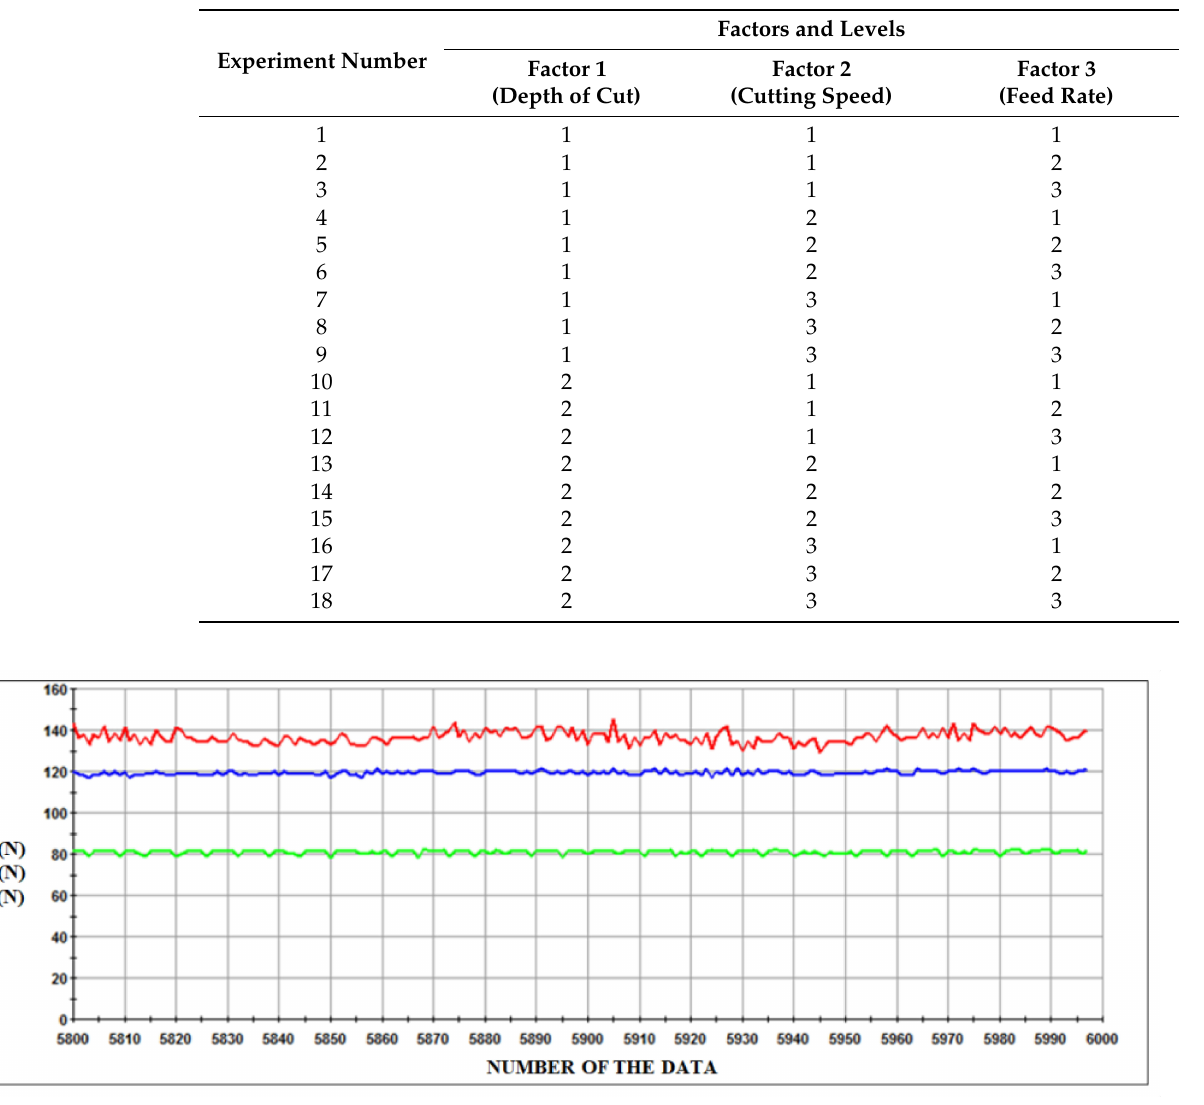
Table 2. Taguchi L 18 factorial plan.